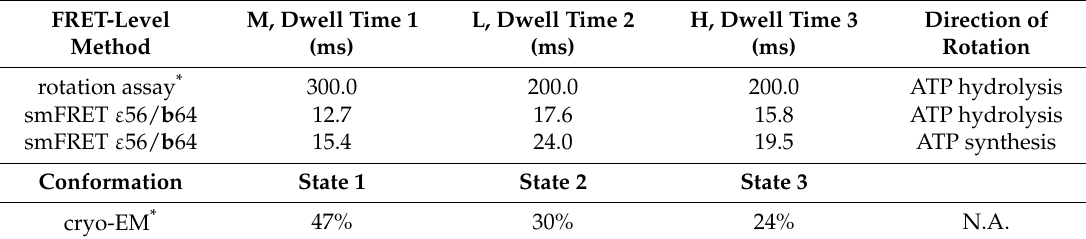
Table 2. Dynamic and static differences of measurements with EcF O F 1 . The top part shows the dynamic differences in dwell times for the three catalytic dwells found in our single-molecule fluorescence experiments. For comparison, the bottom row shows the static distribution of the three different states in the cryo-EM measurement. (* FRET-levels do not apply to this